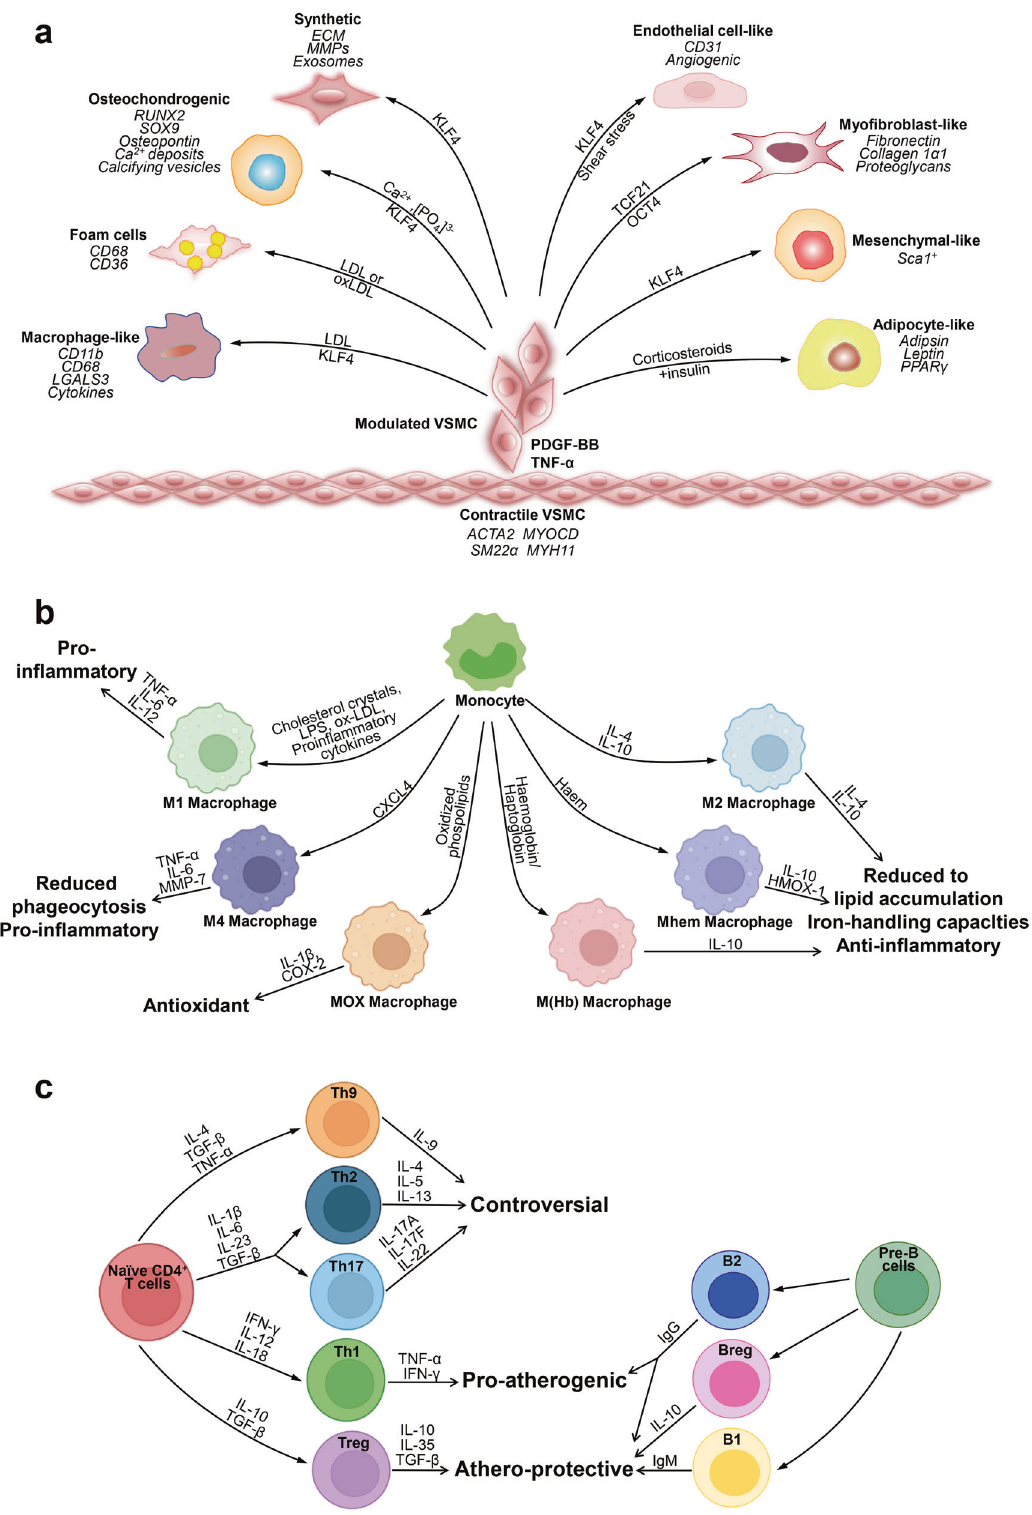
protecting against vascular in fl ammation and oxidative stress, accumulation of SM22 α protein accelerates senescence of VSMCs and vascular aging via suppression of murine double minute 2 (Mdm2)-mediated degradation of p53 in vitro and in vivo.